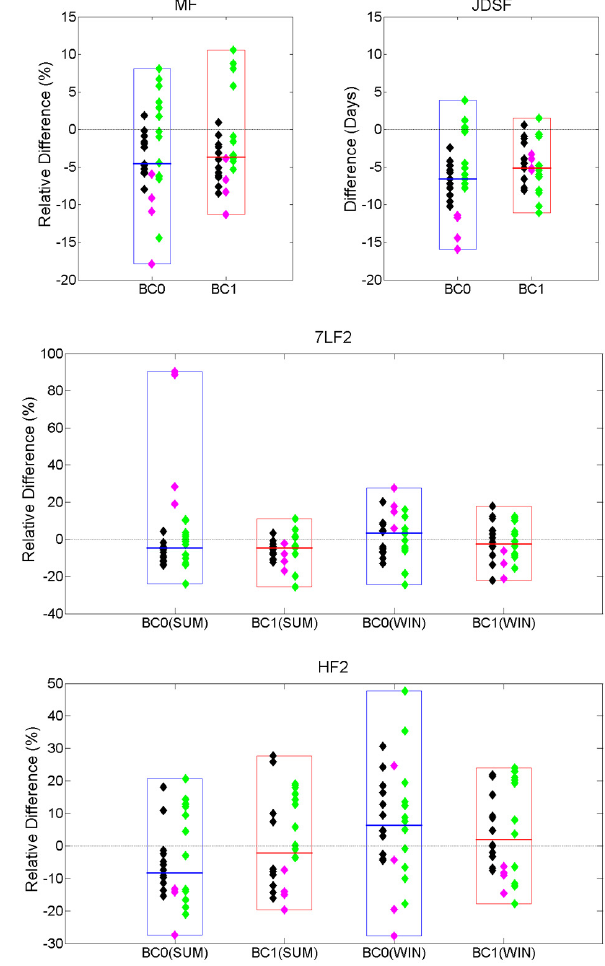
Fig. 7. Relative change of the investigated indicators between ref- erence and future period at Saumon based on five members of the CRCM–CGCM ensemble over Qu´ebec.